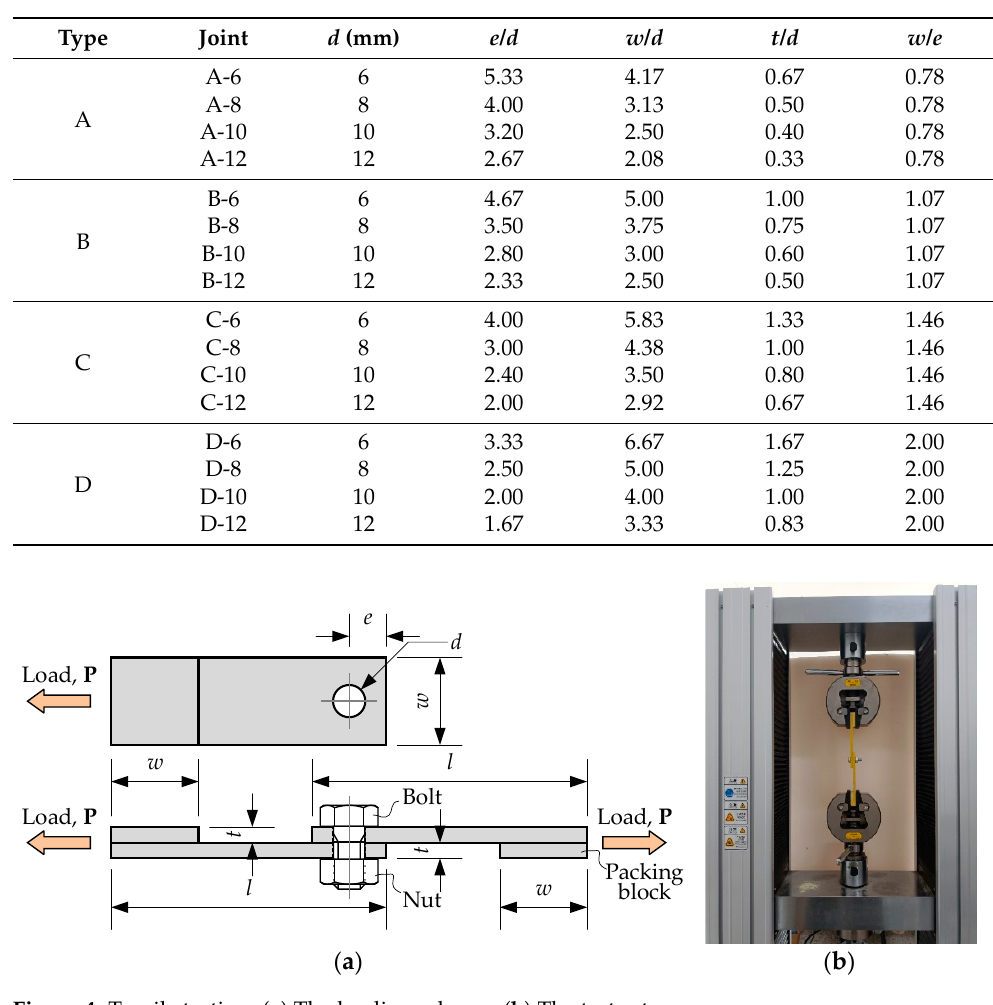
Figure 4. Tensile testing: ( a ) The loading scheme; ( b ) The test setup. Table 3. Configuration of the test samples.